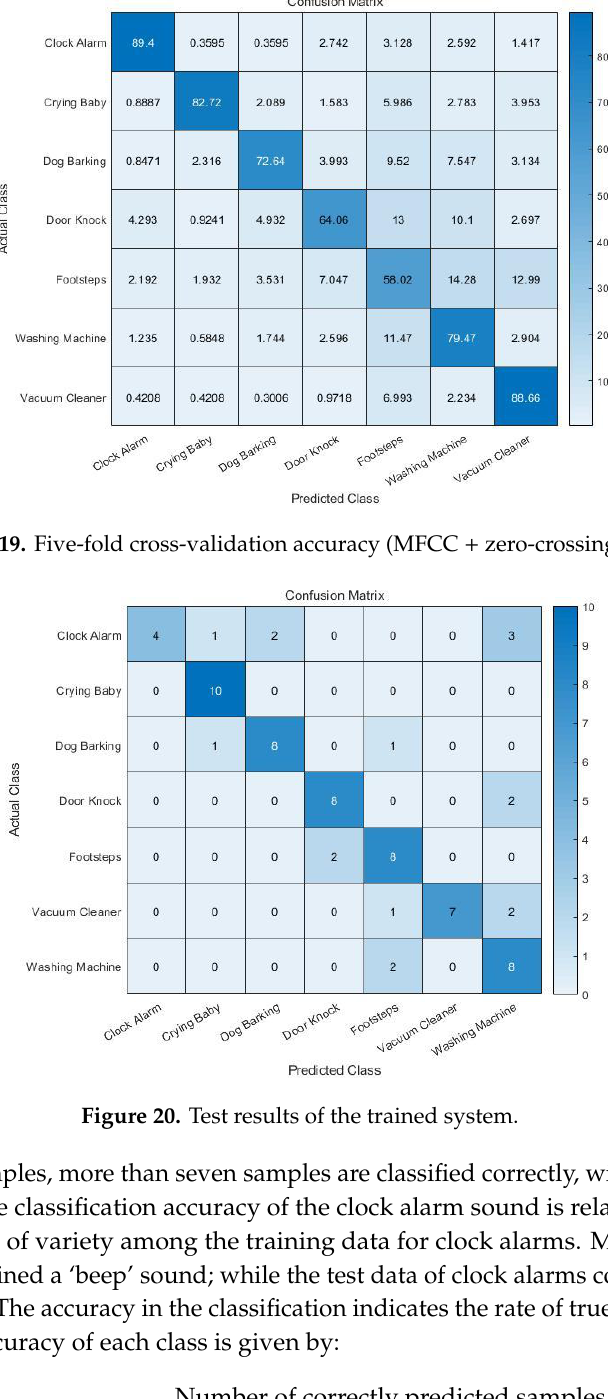
15 of 18 Figure 18. Five-fold cross-validation accuracy (MFCC only).